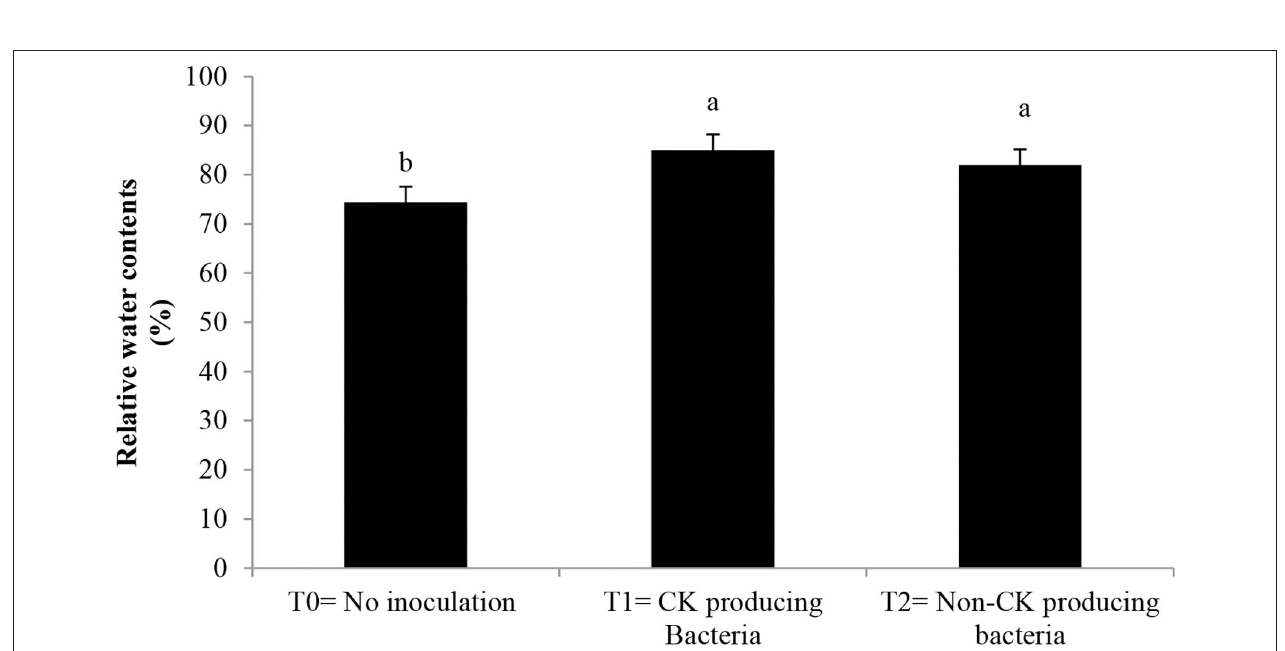
FIGURE 4 | Effect of Ck producing A. brasilense RA − 17 and non-producing A. brasilense RA − 18 on relative water content (RWC, %) of wheat. T0 = no inoculation; T1 = Ck producing strain, and T2 = non-Ck producing bacterial strains. The different letter shows a significant difference in treatments at a 5% probability level.